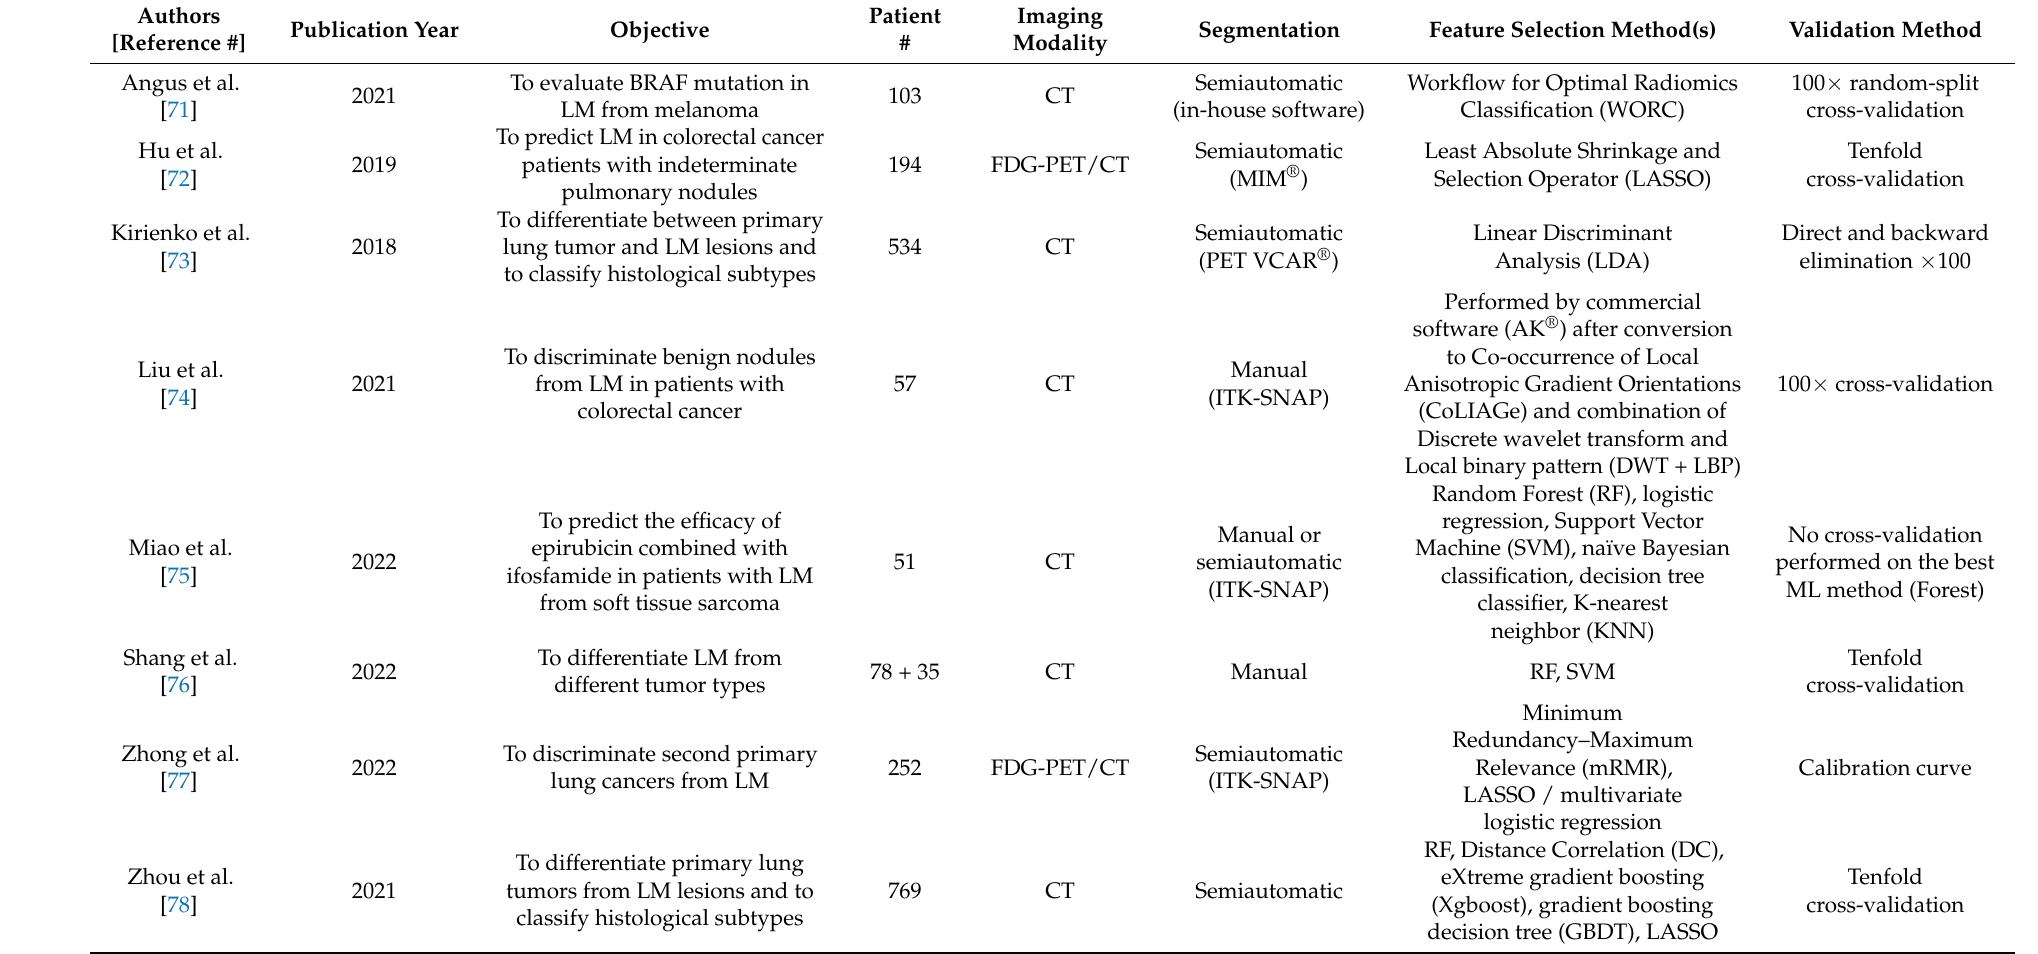
Table 1. Methodology and main findings of the 8 articles selected. ML = Machine